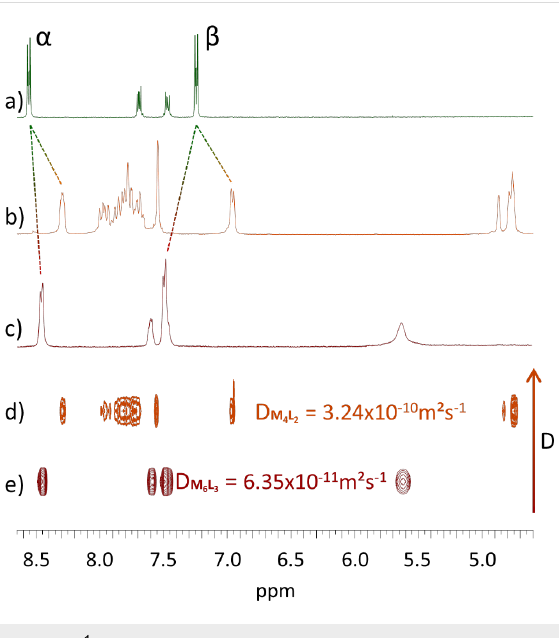
Figure 2: 1 H NMR, downfield region ( α and β signals correspond res- pectively to α and β pyridyl protons): (a) L1 (DMSO- d 6 ), (b) M 4 L 2 (CD 3 NO 2 ), (c) M 6 L 3 (DMSO- d 6 ), (d) DOSY NMR of M 4 L 2 (CD 3 NO 2 ) and (e) DOSY NMR of M 6 L 3 (DMSO- d 6 ).